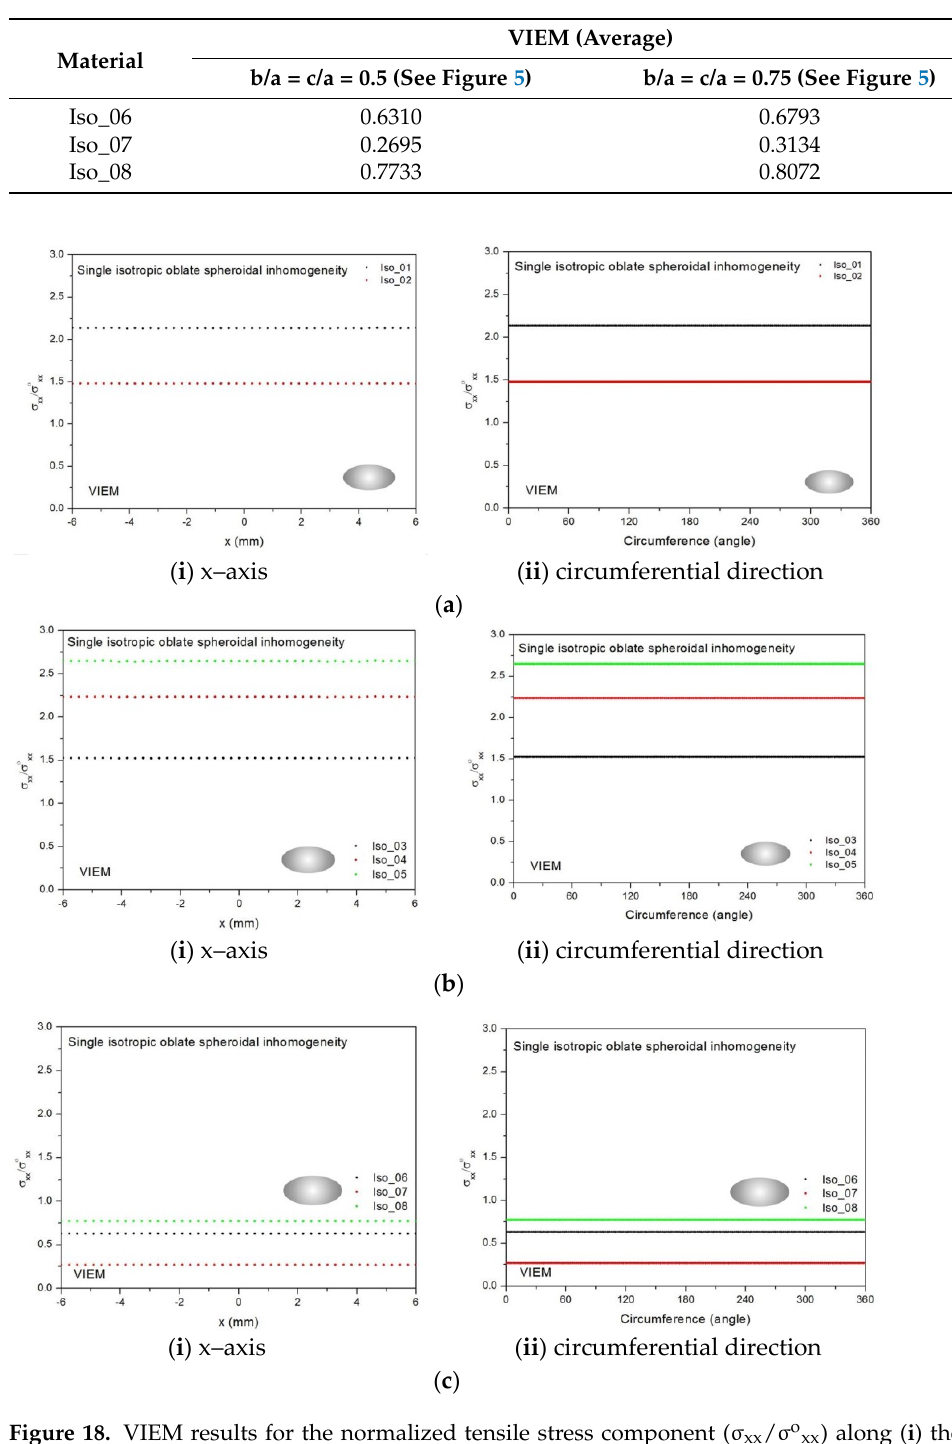
Table 16. Normalized tensile stress component ( σ xx / σ o xx ) within the isotropic oblate spheroidal inclusion due to uniform remote tensile loading ( σ o xx ).